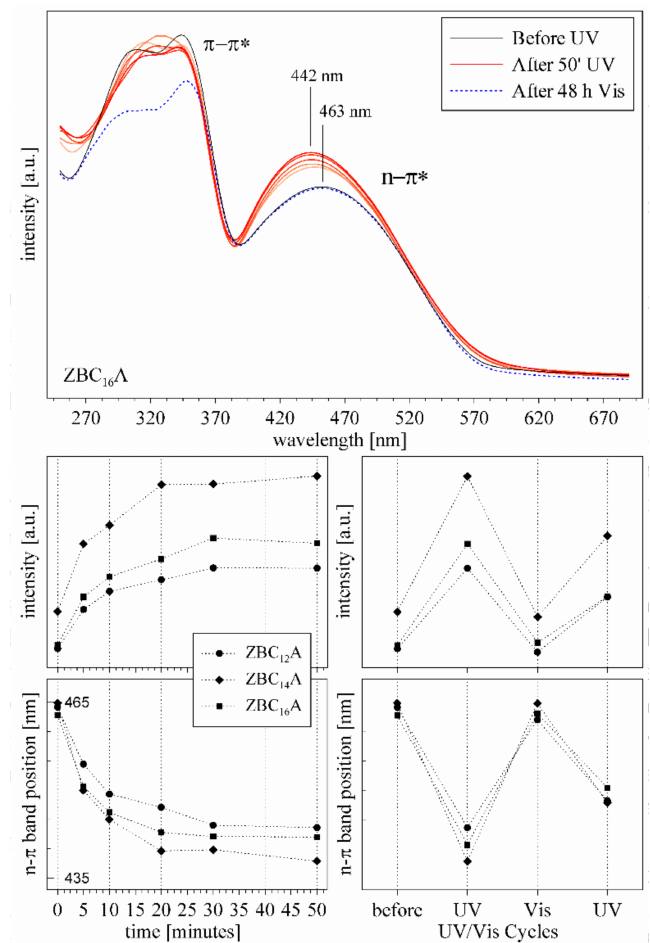
Figure 7. Upper graph: the UV–Vis spectra of ZBC 16 A sample before and after UV irradiation (in 10 min time periods), and after 48 h of relaxation. Lower graphs show the change of the intensity and the position of the n– π * band versus time of UV irradiation, and upon alternating UV–Vis